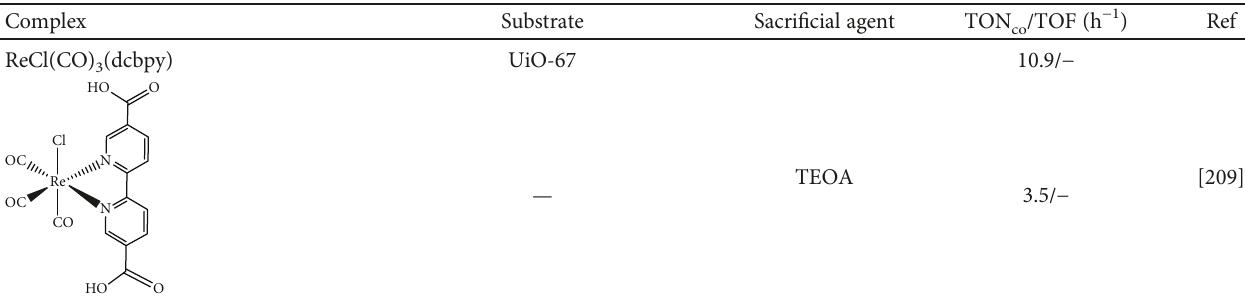
ByPh: 2,2 ′ -bipyridine-4,4 ′ -bisphosphonic acid; pic: picoline; PyBn: 1-(2-picolyl)-4-phenyl-1H-1,2,3-triazole; L1: 4,4 ′ -dipropionylamido-2,2 ′ -bipyridyl; dcbH 4 4-dicarboxylic acid-2 2-bipyridine; phdo: 5,6-dione-1,10-phenantroline; dcbpy: (2,2-bipyridine)-5,5-dicarboxylic acid; TiO 2 : titanium dioxide; ZrO 2 : zirconium dioxide; SrTiO 3 : strontium titanate; CeO 2 : cerium(IV) oxide; ITO: indium tin oxide; ZnO: zinc oxide; rGO: reduced graphene oxide; SiO 2 : silicon dioxide;